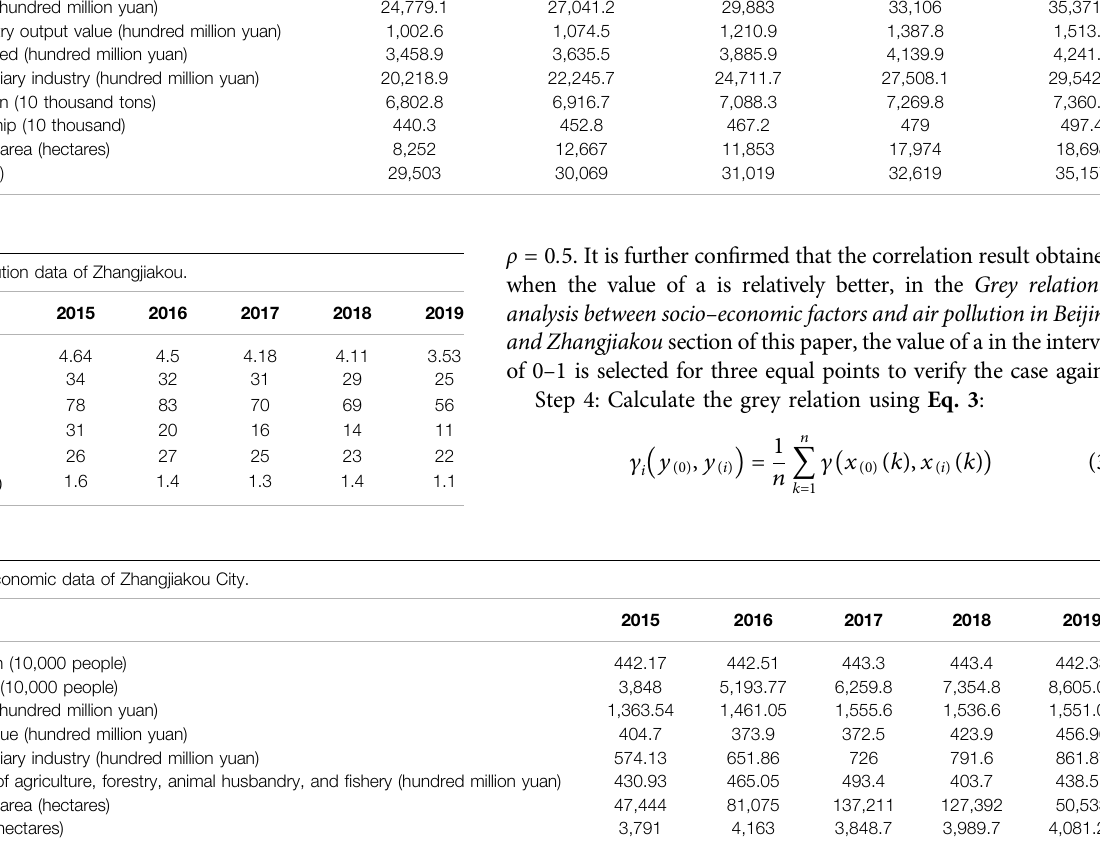
TABLE 2 | Socioeconomic data of Beijing. Indicator Resident population (10,000 people)